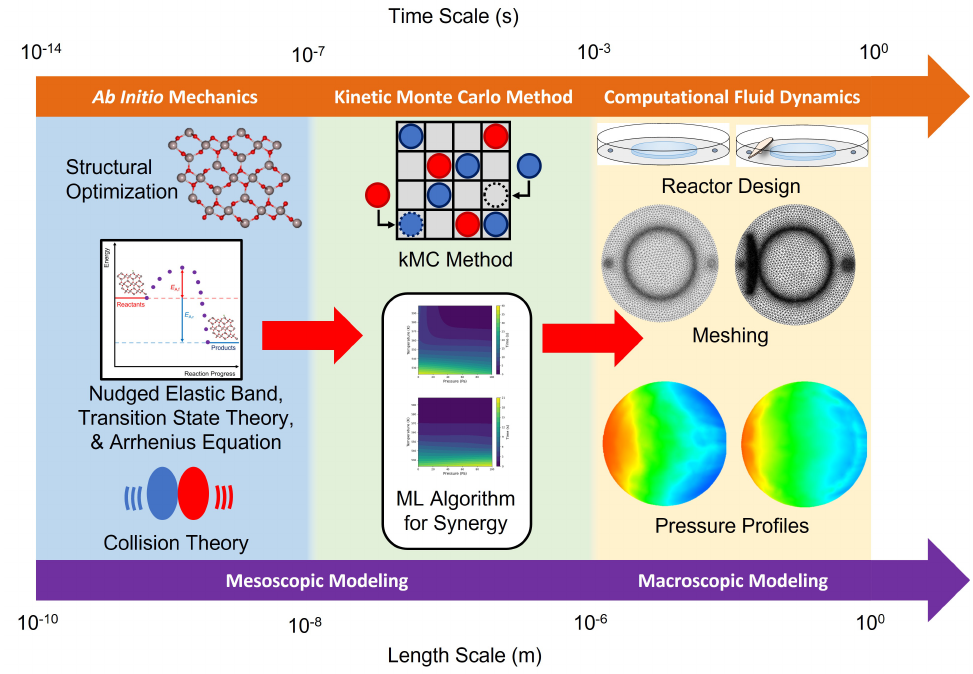
Figure 2. Diagram depicting the various length and time scales applicable for the multiscale modeling simulation, which is composed of mesoscopic and macroscopic modeling. Mesoscopic modeling is composed of ab initio quantum and statistical mechanics and the kinetic Monte Carlo method, and the macroscopic model consists of reactor modeling and computational fluid dynamics simulations. Prior work [49] has utilized machine learning or regression methods to determine optimal operating conditions to achieve high synergy.